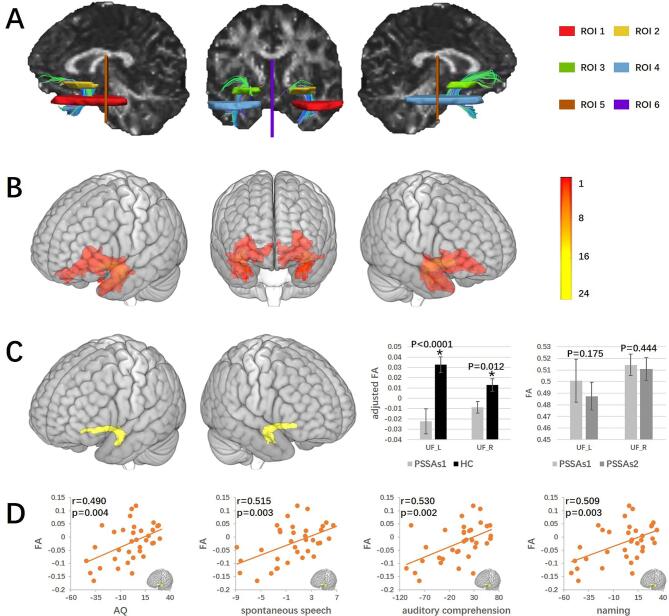
Diffusion tensor tractography results of the bilateral uncinate fasciculus. A. Regions of interest for reconstructing the bilateral UF and reconstructed bilateral UF from 1 healthy subject. ROIs 1 and 2 were used to include fibers of the left UF; ROIs 3 and 4 were used to include fibers of the right UF; ROIs 5 and 6 were used to remove unrelated fibers. B. Overlap of the bilateral UF for 24 HCs. The color indicates the number of participants having the UF passing through a given location. C. The templates of the bilateral UF with plots showing the comparison of bilateral UF FA values (mean ± standard deviation) between HCs and baseline PSSA patients, and between patients in session 1 and session 2. Baseline PSSA patients showed significantly reduced FA value in the bilateral UF as compared to HCs, but no significantly changed FA as compared to session 2. D. The correlations between left UF FA value and WAB scores in baseline PSSA patients. The left UF FA value was positively correlated with WAB AQ (p = 0.004), spontaneous speech (uncorrected p = 0.003, FDR p = 0.004), auditory comprehension (uncorrected p = 0.002, FDR p = 0.004), and naming (uncorrected p = 0.003, FDR p = 0.004) scores in PSSA patients. Note that due to partial correlations, axes show the residuals of parameters. Abbreviation: UF: uncinate fasciculus; FA: fractional anisotropy. ‘*’ indicates statistical significance (P < 0.05).